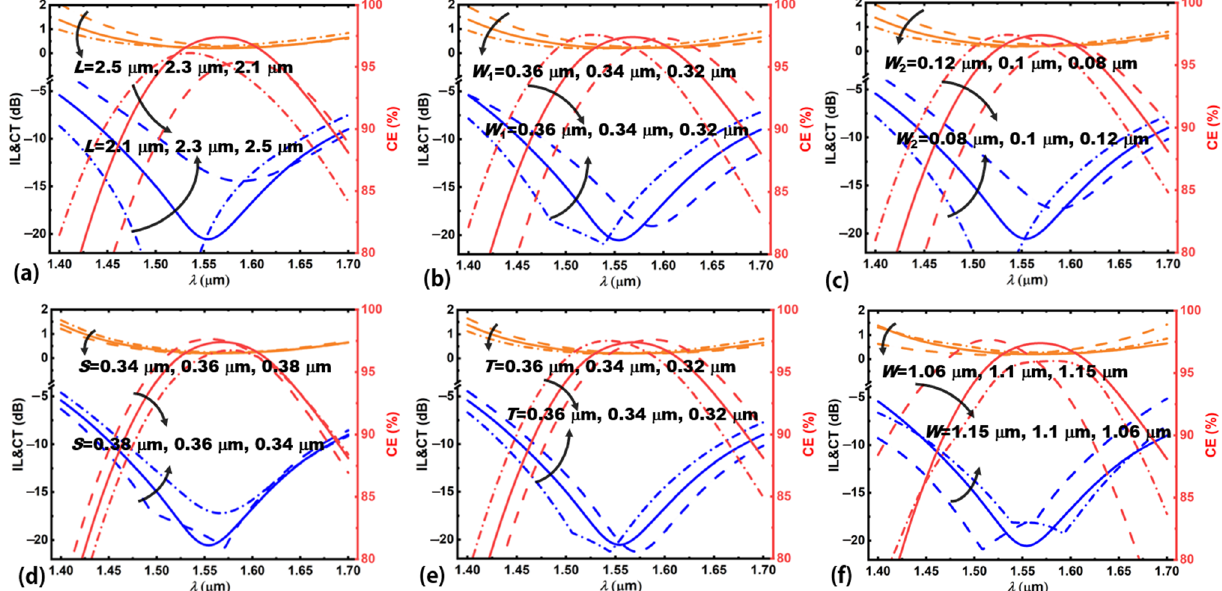
Figure 8. Wavelength spectra of mode CE, CT, and IL of the proposed device as the following pa- rameters change, ( a ) taper length L , ( b ) input end width W 1 , ( c ) output end width W 2 , ( d ) lateral shift S relative to the centerline of the waveguide, ( e ) Sb 2 Se 3 layer thickness T , and ( f ) silicon waveguide with W . The wavelength range is calculated from 1.4 to 1.7 μm.